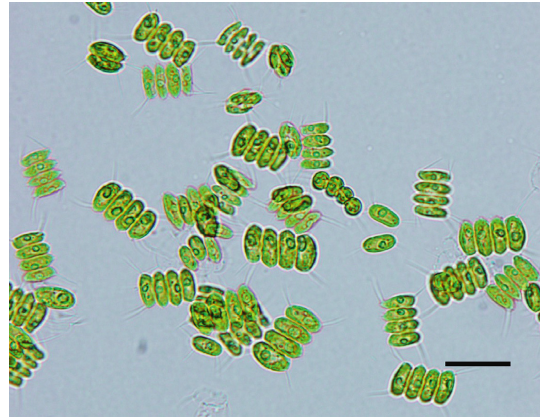
Figure 1: Morphology of colonies of Scenedesmus sp. under a microscope. Scale bar: 20 μ